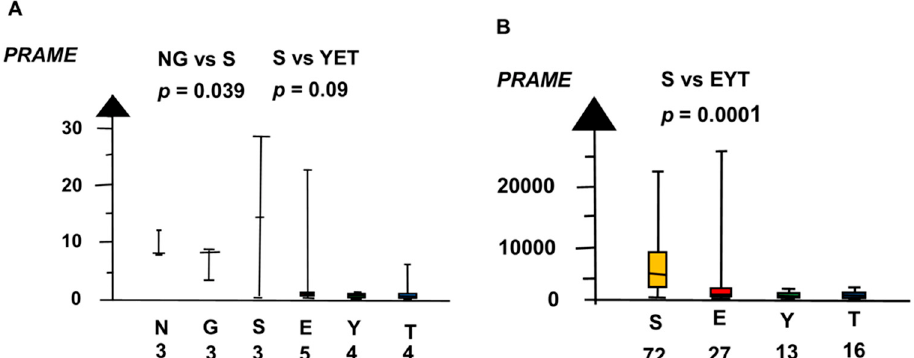
Figure 1. RNA expression of PRAME in the two microarrays ( A , B ) show that normal testis (N), germ cell neoplasia in situ (G) and seminoma (S) had high RNA expression and embryonal carcinoma (E), yolk sac tumor (Y), and teratoma (T) had a low RNA expression. The boxes show the median and the upper and lower quartiles and the whiskers show the full range.